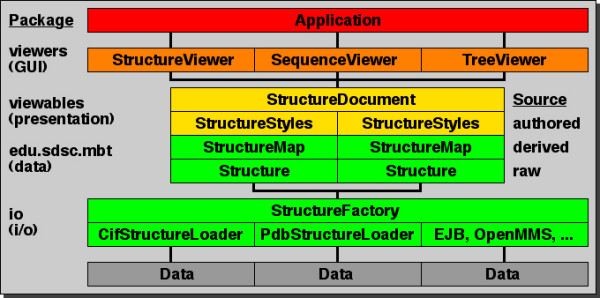
The architecture of the toolkit.